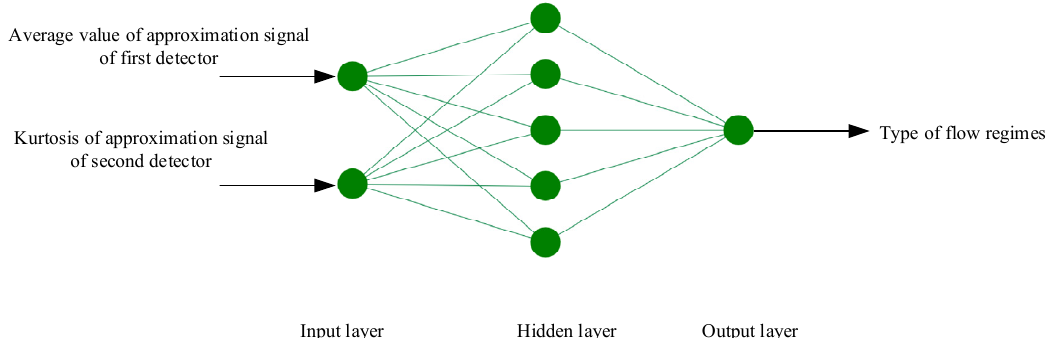
Figure 8. Network structure for regime classification.